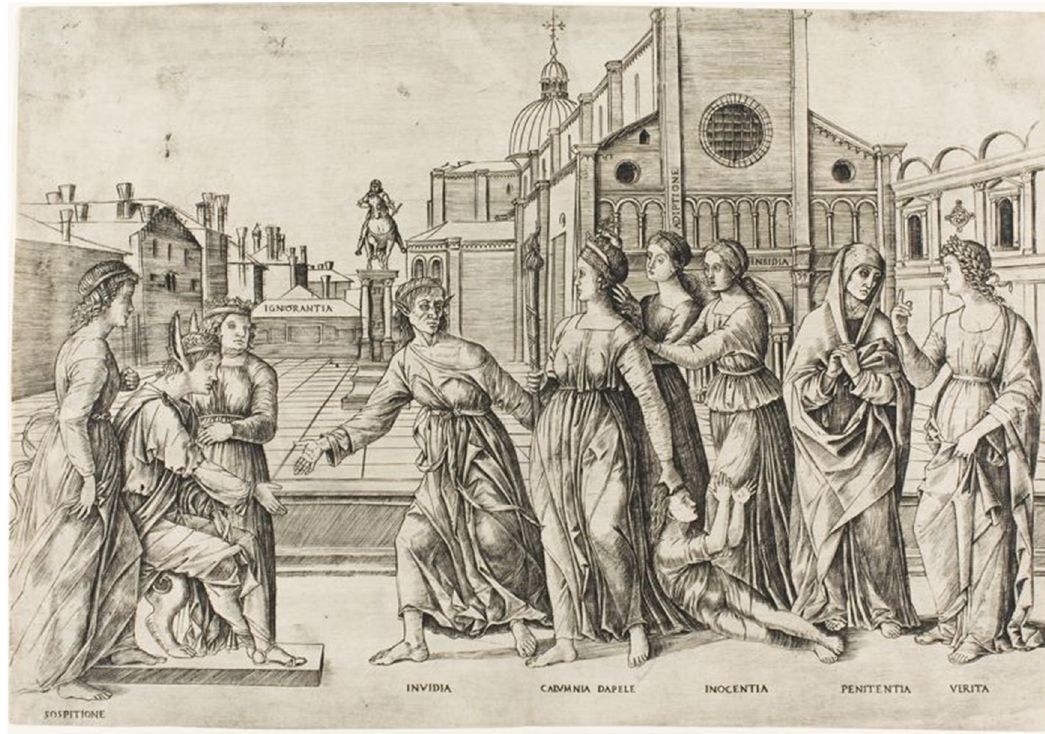
Figure 15: Girolamo Mocetto, Calumnia , 1500. British Museum, London. Public